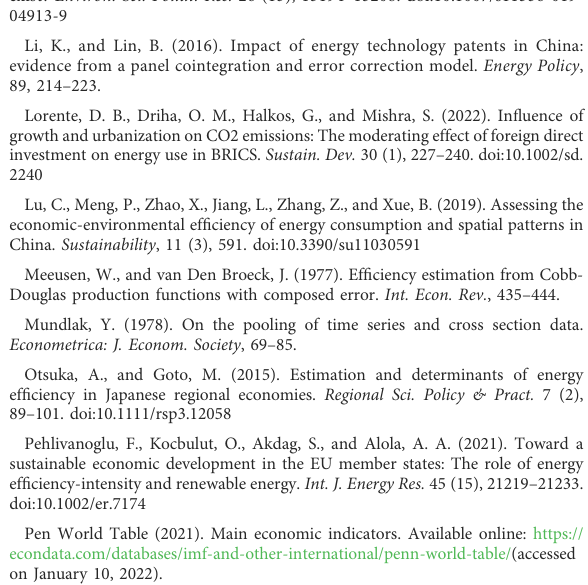
Pen World Table (2021). Main economic indicators. Available online: https:// econdata.com/databases/imf-and-other-international/penn-world-table/(accessed on January 10,